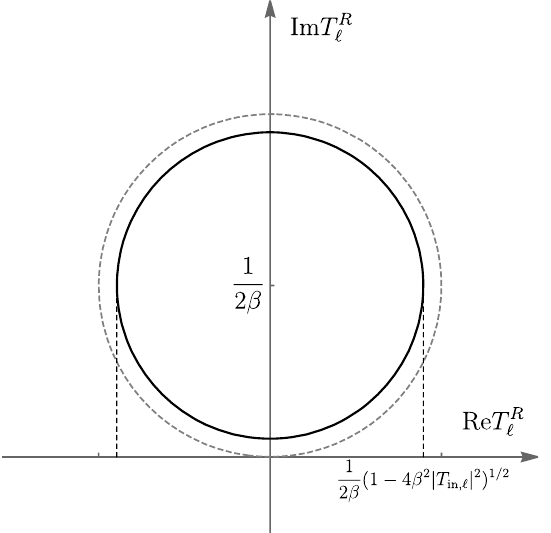
Figure 1 . Unitarity circle on a complex plane of the partial-wave amplitude for the elastic scattering with a fixed partial-wave amplitude squared for the inelastic scattering. Unitarity circle without the inelastic scattering is shown as the gray-dashed